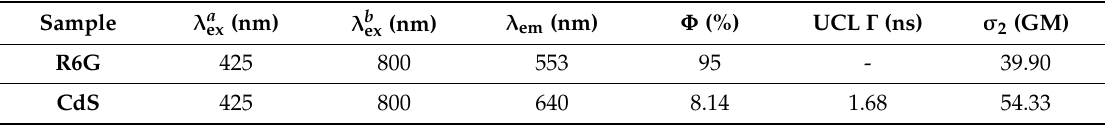
Figure 4. ( a ) Absorption and fluorescence spectrum of the CdS QDs, the blue line and black line represent the absorption spectrum and fluorescence spectrum, respectively; ( b ) Fluorescence and two-photon excited fluorescence spectrum of the CdS QDs, the solid line and dash dot line represent the fluorescence spectrum and two-photon excited fluorescence spectrum, respectively; ( c ) Power dependence of two-photon excited fluorescence intensity of CdS QDs on 800 nm excitation power; ( d ) The schematic diagram of the two-photon absorption process induced deep defect states fluorescence. Table 2. Quantum efficiency, two-photon absorption cross-section and fluorescence lifetime of the CdS QDs measured by R6G.